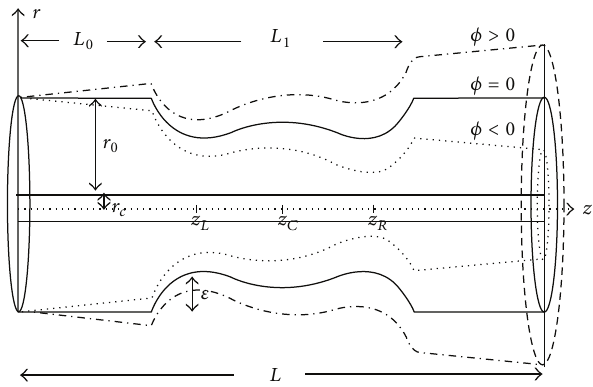
Figure 1: Overlapping stenotic tapered artery with catheter.